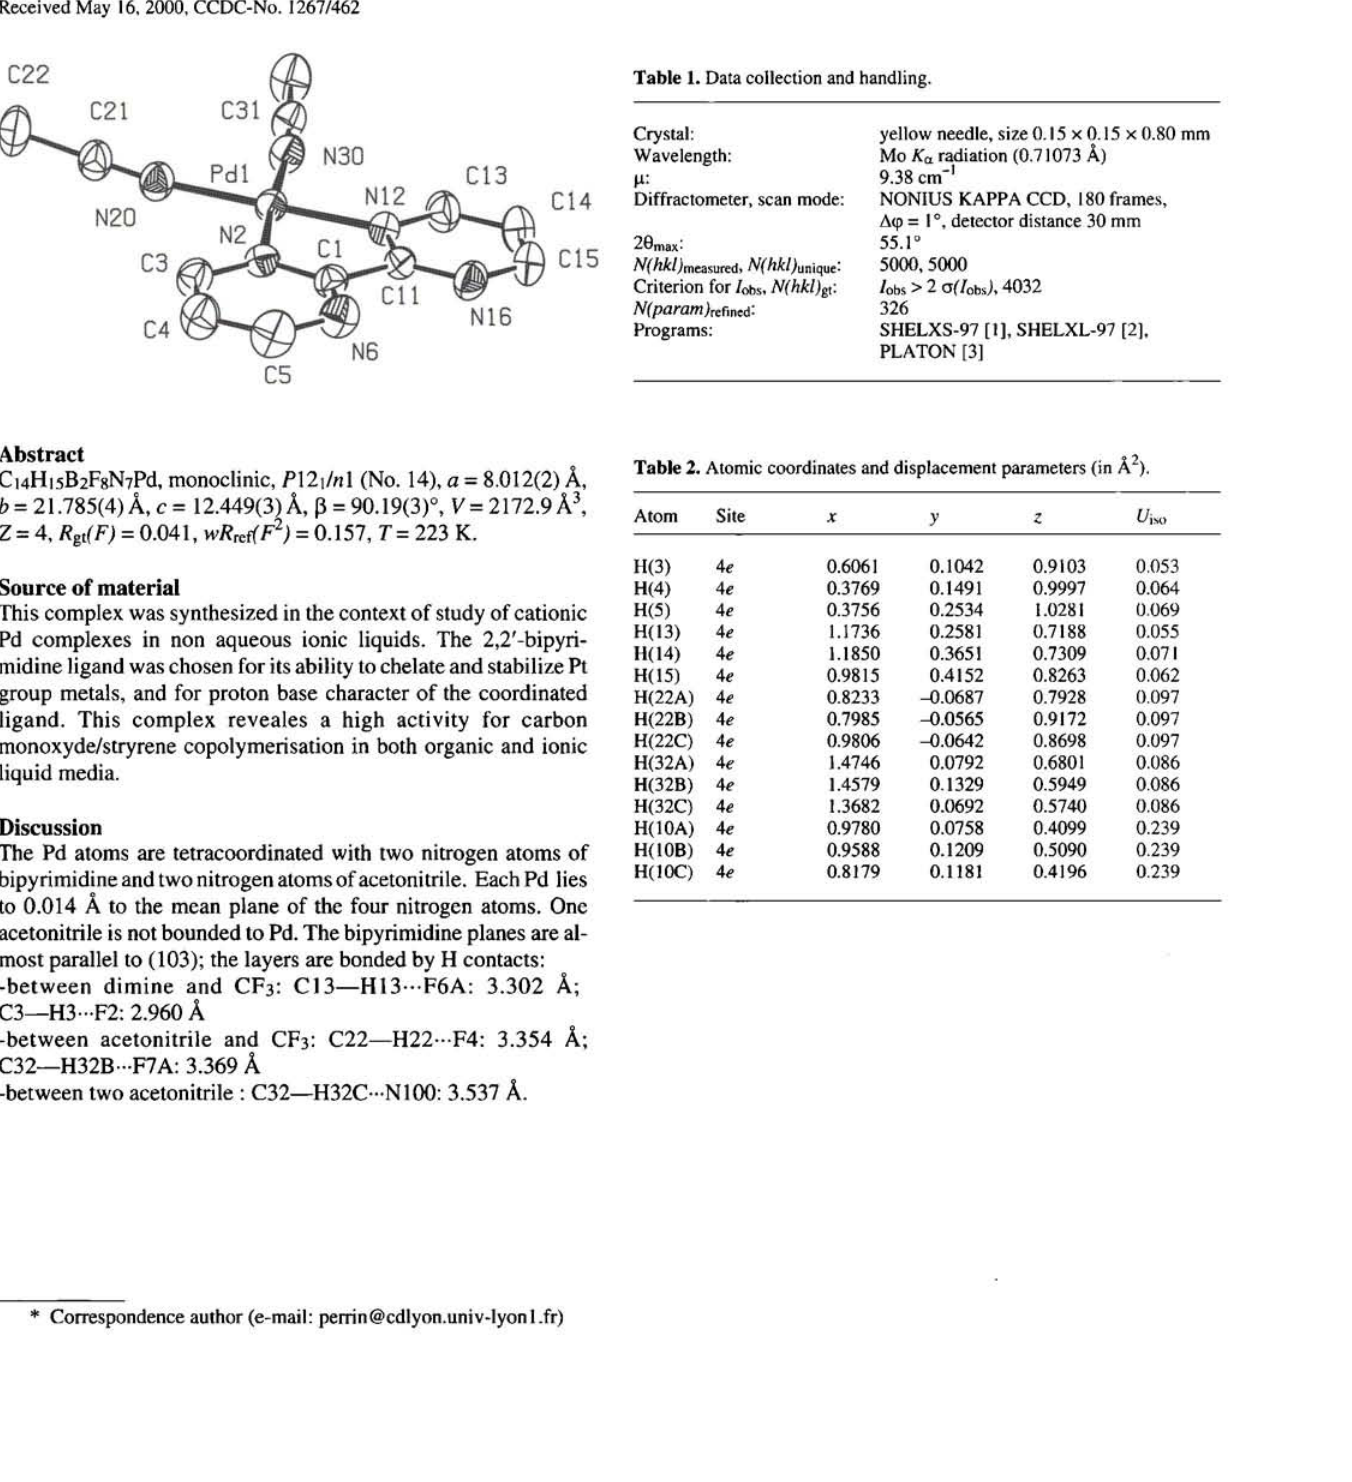
Table 1. Data collection and handling.